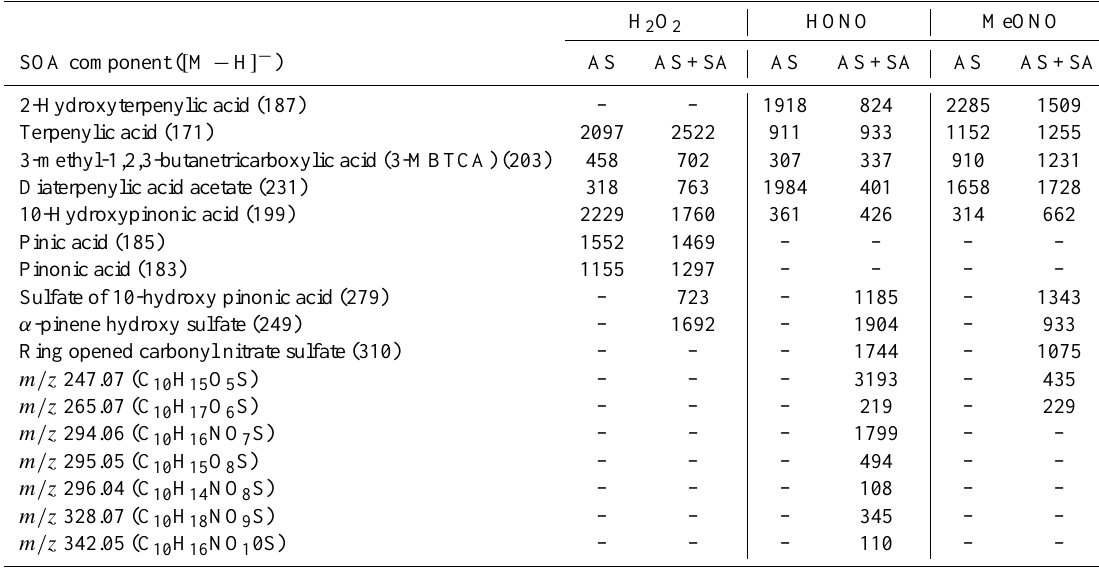
Table 2. Raw peak areas from UPLC chromatograms of carboxylic acids, organosulfates, and nitrooxy organosulfates from the photooxida- tion of α -pinene.